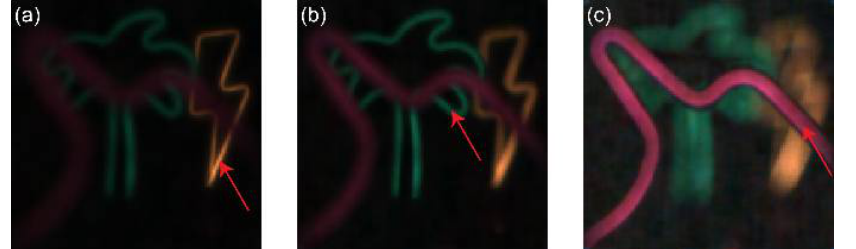
Figure 9. The images digitally refocused of the self-luminous objects at ( a ) the farthest object, ( b ) the middle object, and ( c ) the nearest object indicated by the red arrow respectively (see Visualization S4).